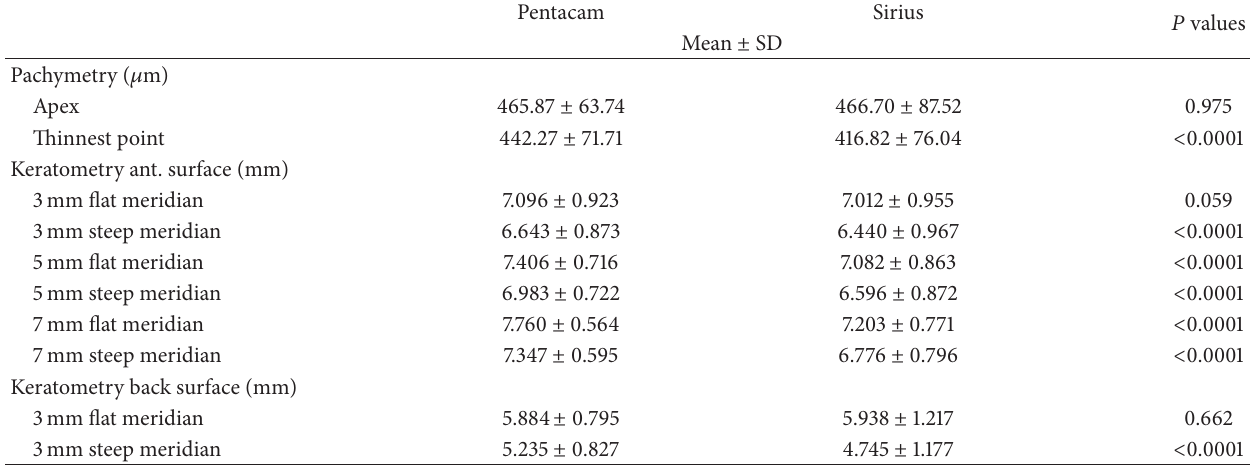
Table 4: Interdevice differences of the two devices in keratoconus patients.